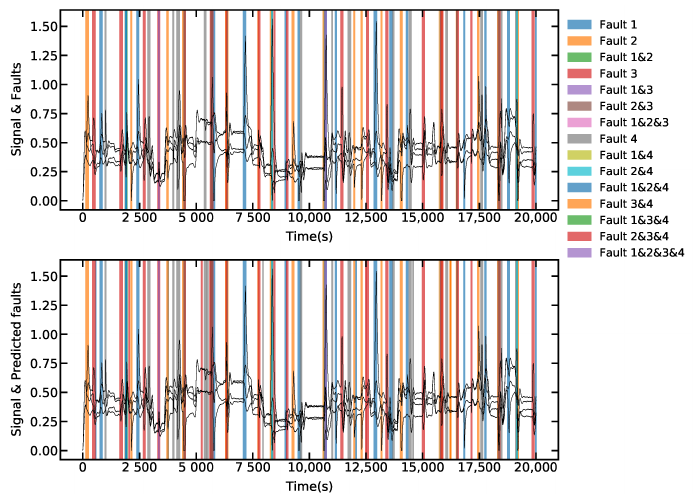
Figure 9. Sensor faults detection, the faults are represented in the shaded areas, states are given in black for reference. Above: faults labeled in the data-set. Below: faults detected by the